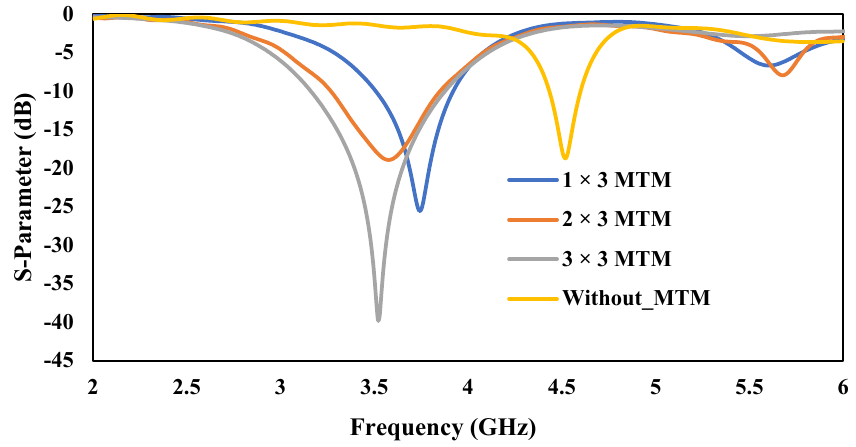
Figure 10. S-Parameter Response by varying the number of Cross-Slot MTM structure.